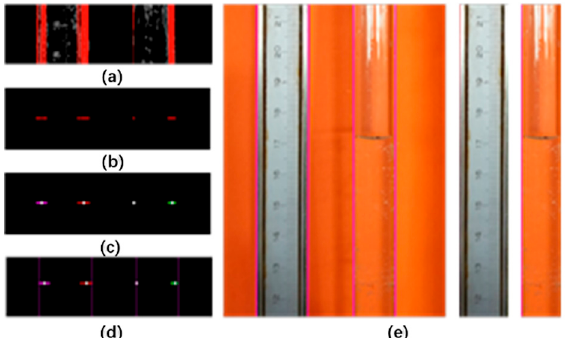
Figure 9. The result of image segmentation using the K-means clustering algorithm, including ( a ) the initial linear edge data, ( b ) the cluster data set, ( c ) clustering results and cluster centers, ( d ) clustering four, ( e ) an effect map based on clustering edge segmentation